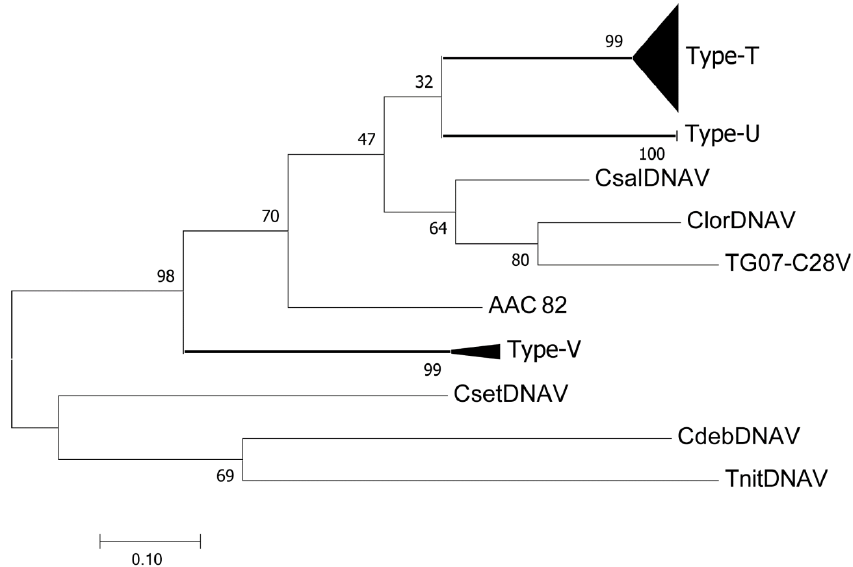
Figure 2. Phylogenetic analysis of ssDNA viruses. Maximum likelihood (ML) trees of ssDNA viruses based on replication protein sequences. Bootstrap values (percent) from 1000 replicates are shown at the nodes. ML distance scale is shown under the ML